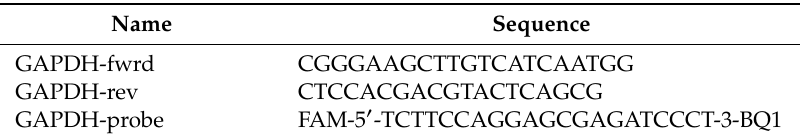
Table 2. GAPDH ddPCR primers and